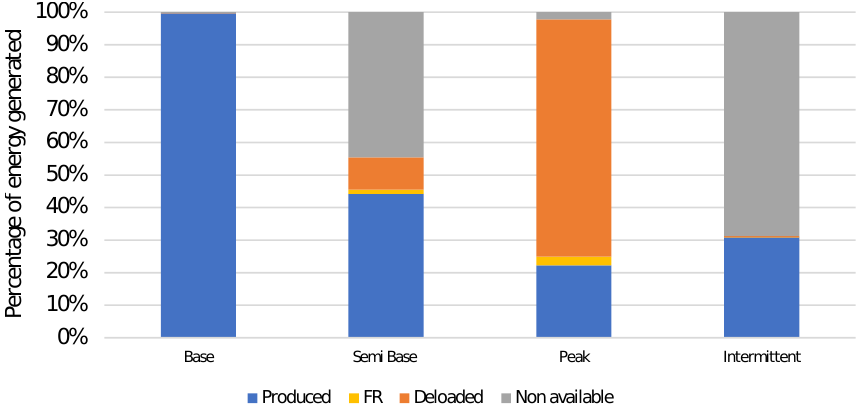
Figure 3. Energy breakdown per technology type for Case study